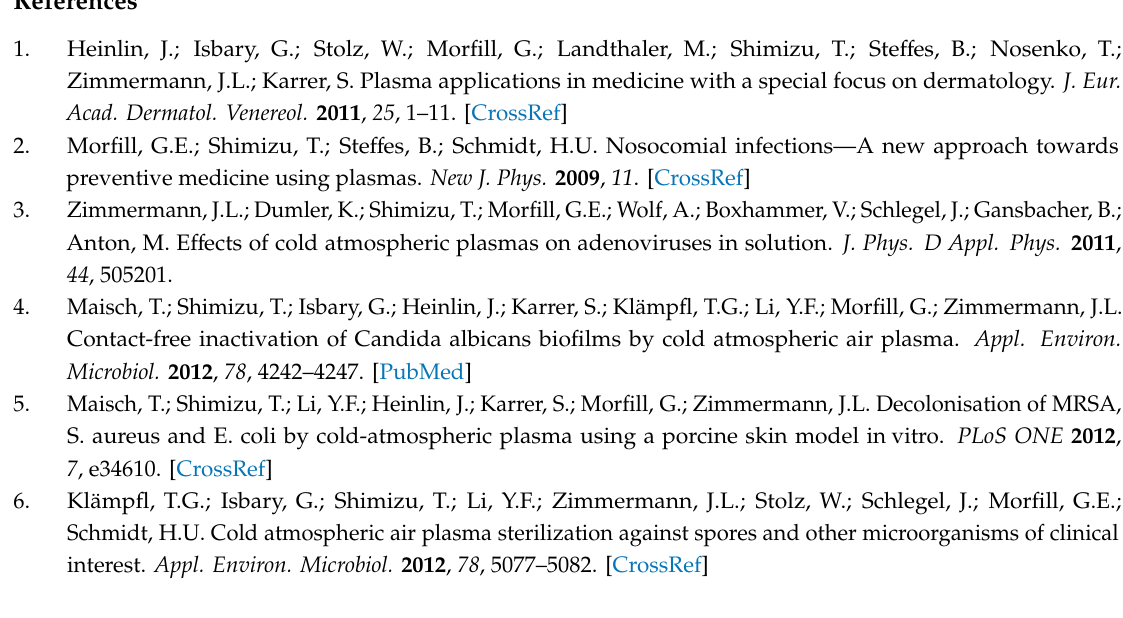
Figure S1: The CAP-induced intracellular Ca 2 + influx is pH dependent, Figure S2: CAP-produced reactive species vary in di ff erent media, Figure S3: The CAP-induced acidification could be inhibited by NaN 3 , Figure S4: Application of H 2 O 2 onto melanoma cells causes a minor Ca 2 + influx, Figure S5: Whole blots of the Western Blot analysis of CAP-induced protein nitration after direct CAP treatment of Mel Im and Mel Juso cells, shown in Figure 4F, Table S1: Densitometric evaluation of the Western Blot analysis shown in Figure